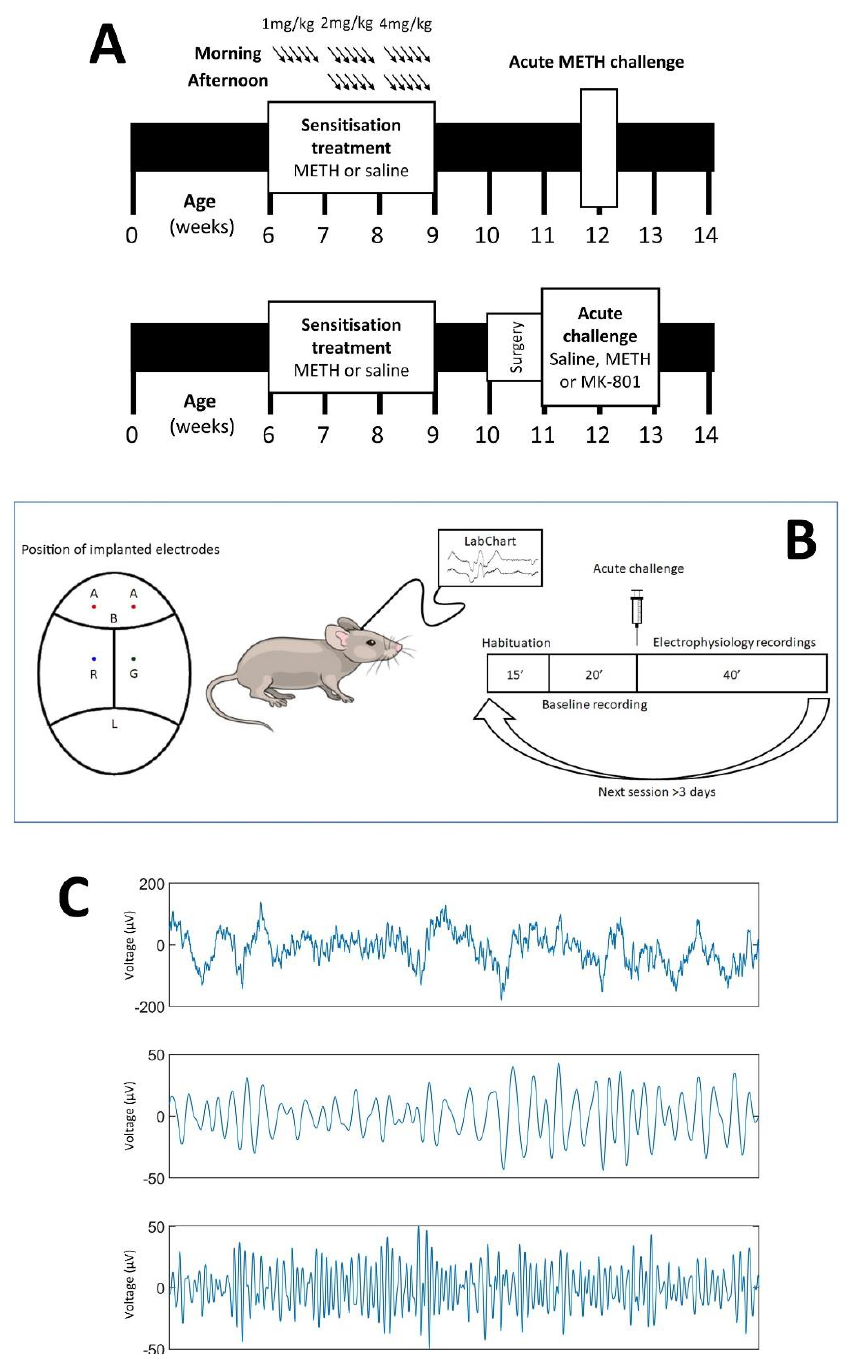
Figure 1. ( A ): Experimental timeline. Starting at 6 weeks of age, mice were treated with an escalating dosage regimen of METH or saline control each weekday for 3 weeks. The behavioural cohort (top) was subsequently tested at 12 weeks of age for the effect of an acute METH challenge on locomotor activity. The EEG cohort (bottom) underwent stereotactic surgery at 10 weeks of age to implant recording electrodes. ( B ): Location on the mouse skull where the electrodes are implanted (A = active; R = reference; G = ground), and a schematic of the experimental setup and daily procedure for recording. Over two weeks, three EEG sessions were conducted, during which the effect of METH or MK-801 was compared to saline control. ( C ): Example of a representative 2 s EEG recording at baseline. Top trace is unfiltered signal, middle trace is beta band (20–30 Hz) filtered and bottom trace is gamma band (30–80 Hz) filtered. Vertical scale depicts voltage ( µ